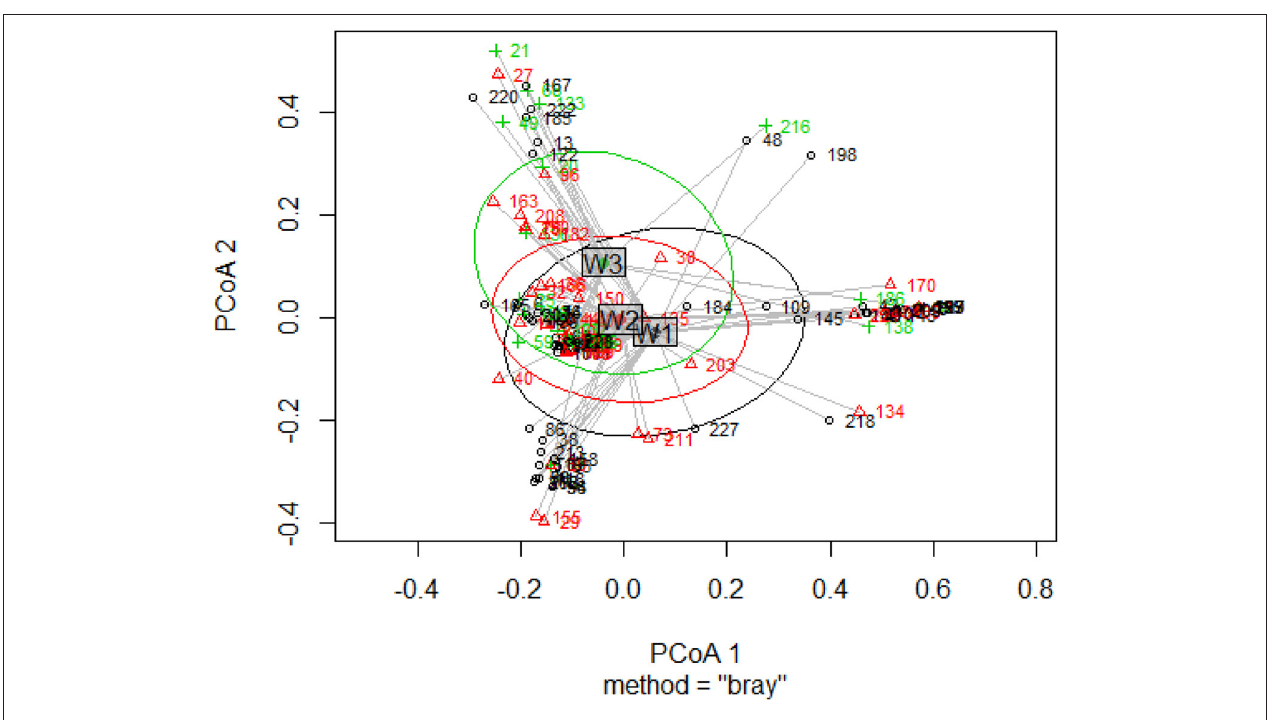
FIGURE 2 | Tree species composition among the three wards of the National District of Santo Domingo, Dominican Republic. Each number corresponds to plots randomly distributed within the three localities: W1 (Ward 1) = black color and open circles, W2 (Ward 2) = red color and triangles, W3 (Ward 3) = green color and crosses. [PCoA1] and PCoA2 explained 15% of the variation among the